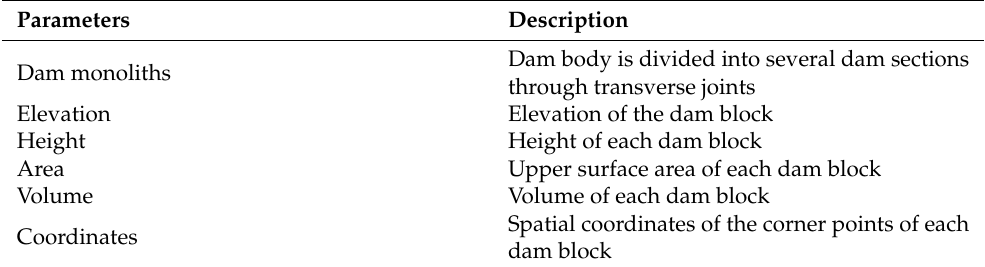
Table 1. The dam body shape parameters.